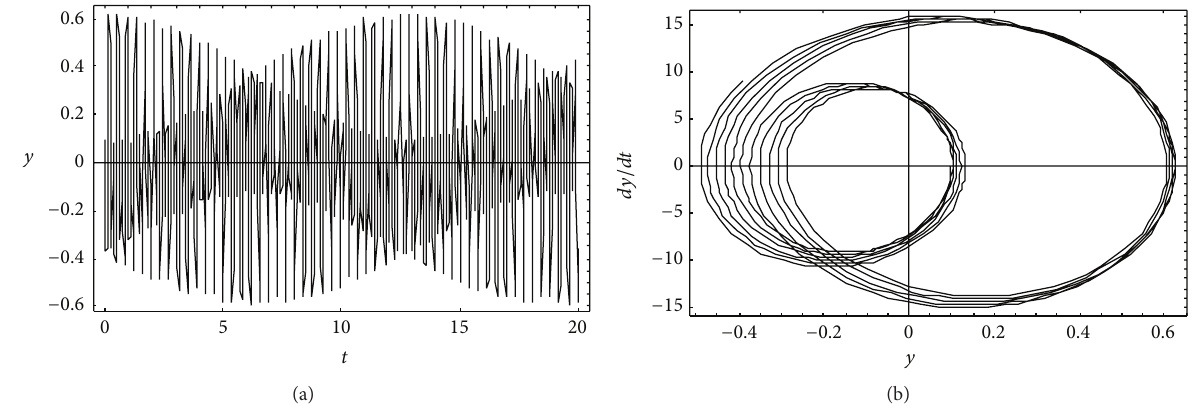
Figure 4: Time domain curve and phase plane about the systems 𝜎 = 0 , 𝛾 = 𝜋/3 .